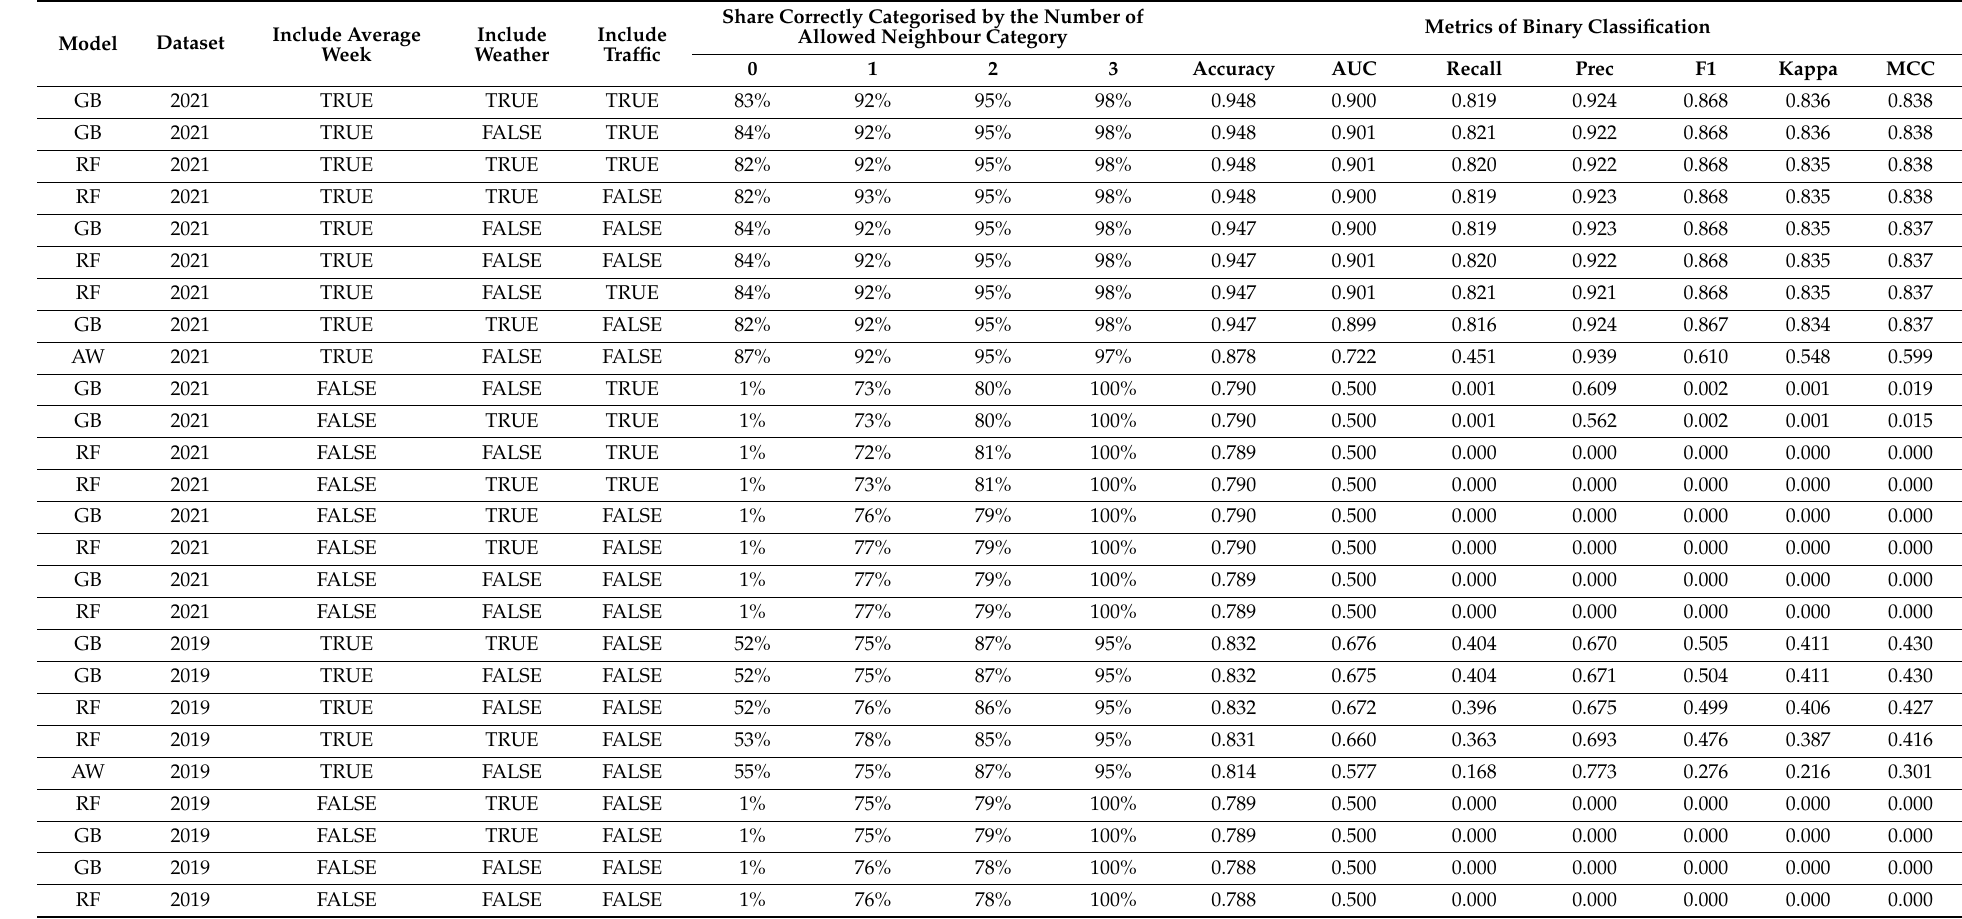
Table 4. Summarised prediction performance of selected model dataset, sorted by dataset first and then by